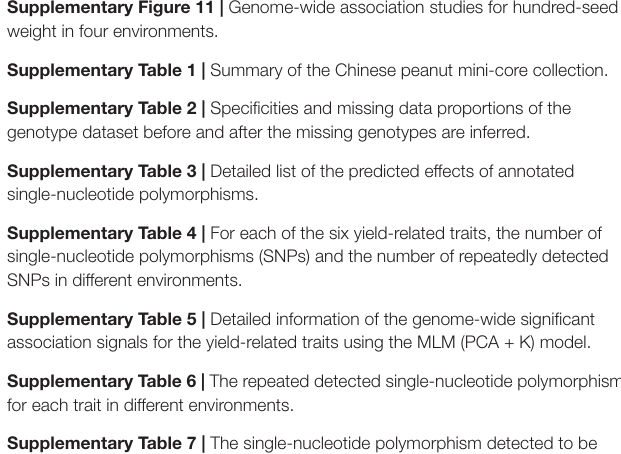
Supplementary Figure 3 | Linkage disequilibrium decay for the Chinese peanut mini-core collection. Supplementary Figure 4 | The number of different botanical subspecies in each group. Supplementary Figure 5 | Distribution of pairwise relative kinship estimates. The values of kinship less than 0 were ordered as 0. Supplementary Figure 6 | Genome-wide association studies for pod length in four environments. Supplementary Figure 7 | Genome-wide association studies for pod width in four environments. Supplementary Figure 8 | Genome-wide association studies for seed length in four environments. Supplementary Figure 9 | Genome-wide association studies for seed width in four environments. Supplementary Figure 10 | Genome-wide association studies for hundred-pod weight in four environments. Supplementary Figure 11 | Genome-wide association studies for hundred-seed weight in four environments. Supplementary Table 1 | Summary of the Chinese peanut mini-core